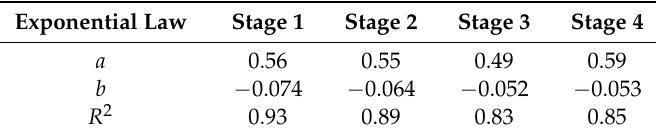
Figure 11. Degree-clustering coefficient correlation. Table 11. Correlation results of degree-clustering